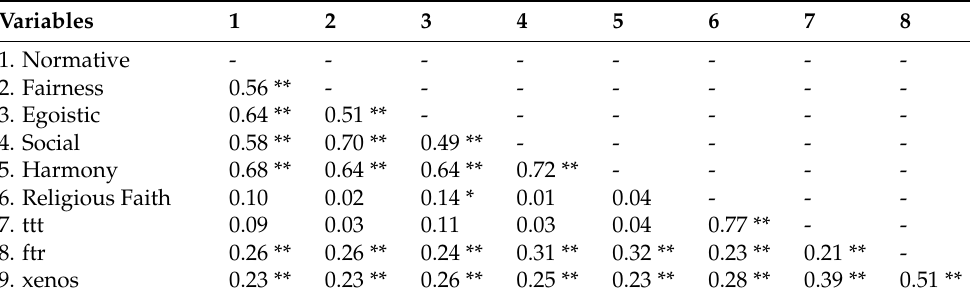
Table 2. Correlations for all